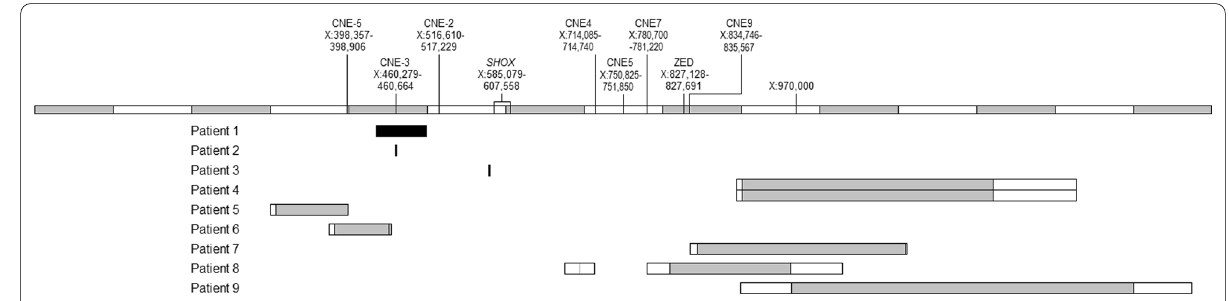
Fig. 1 Region of the X chromosome showing the location of the dosage variants detected in this study, the SHOX gene, the upstream and downstream CNEs, the ZED element and the putative X:970,000 regulatory element. The horizontal bars represent the minimum size (grey for duplications and triplications, black for deletions), and the horizontal white bars extend the variants to their maximum size where